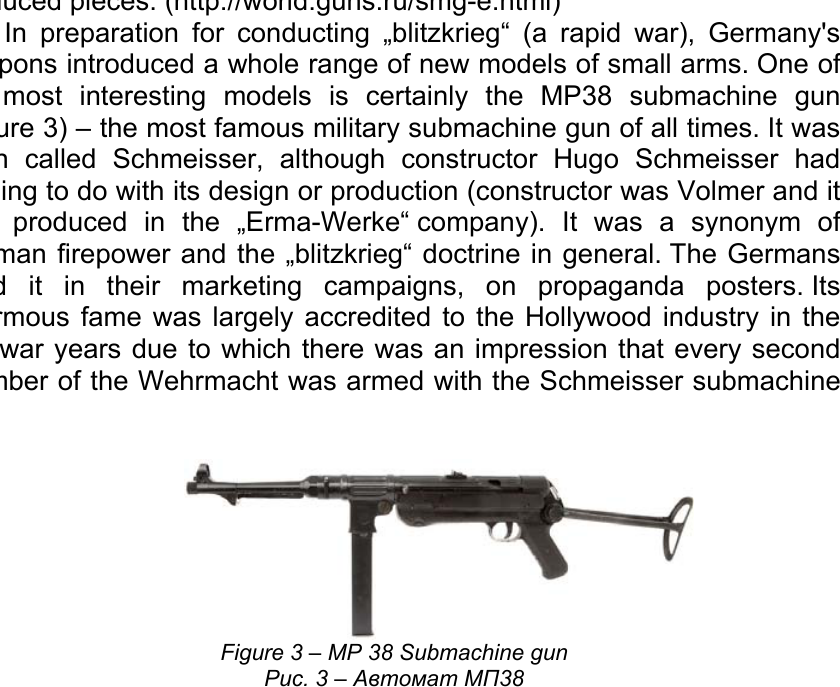
Figure 3 – MP 38 Submachine gun Рис . 3 – Автомат МП 38 Слика 3 – Аутомат